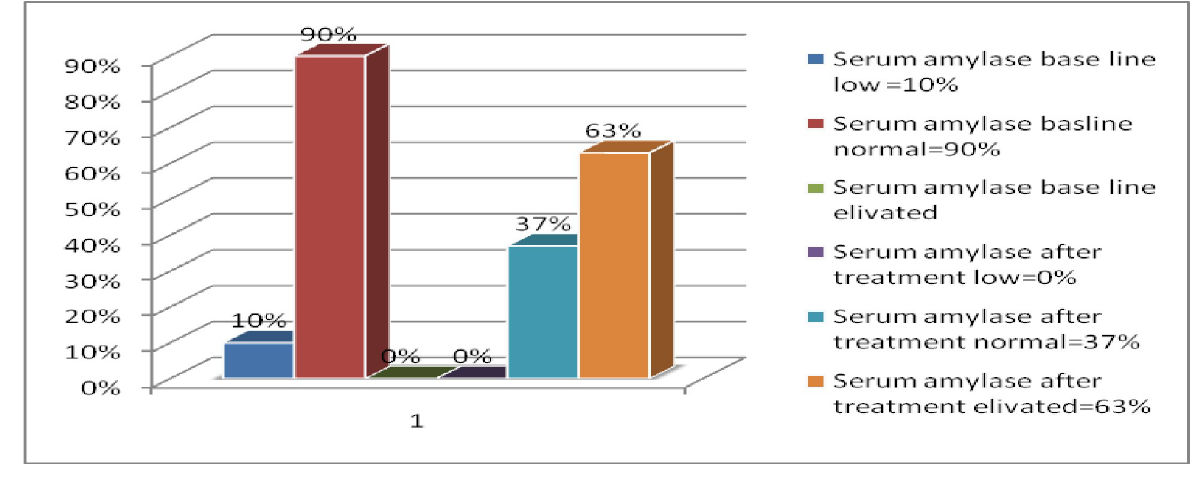
Table 1. Socio-demographic characteristics of study participants. treatment was higher than the mean serum pancreatic amylase before treatment (as shown in Table 2 and Fig 2) Correlation analysis of serum amylase level at TOC with age and base line amylase In this study, pearson correlation analysis was made between pancreatic amylase and demo- graphic characteristics (age). There was a statistically significant and positive association